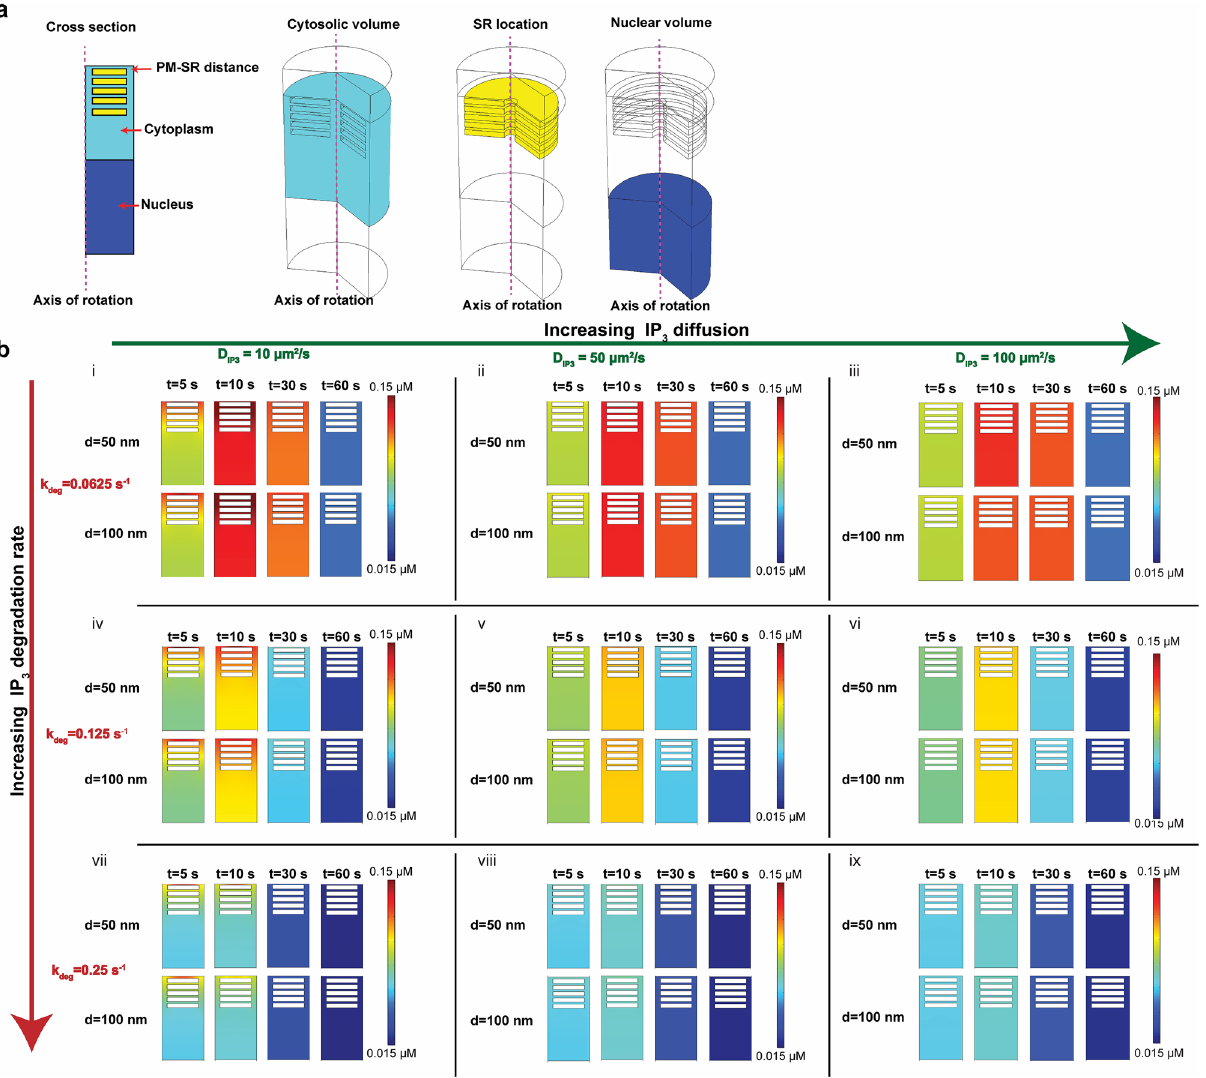
Figure 2. Small length scale simulations in COMSOL show a critical relationship between IP 3 and PM–SR distance. ( a ) Cross-section and geometries representing different compartments governing biochemical events. We model a small part of the cell as a cylinder. The cytosolic volume is shown in cyan, the SR modeled as cylindrical disks shown in yellow and the nucleus is shown in blue and the axis of symmetry is shown in pink. The PM–SR distance, denoted as d in Fig. 1d, is measured between the plasma membrane and the first SR disk. ( b ) Effect of IP 3 diffusion and degradation rate are shown for two different distances between the PM and the SR. Panels (i–iii) show the effect of increasing IP 3 diffusion [(i) 10 μm 2 s −1 , (ii) 50 μm 2 s −1 , and (iii) 100 μm 2 s −1 ] on IP 3 concentration at 5 s, 10 s, 30 s, and 60 s for a degradation rate k deg = 0.0625 s −1 for two different values of d (50 nm and 100 nm). Panels (iv–vi) show similar calculations for k deg = 0.125 s −1 and panels (vii–ix) for k deg = 0.25 s −1